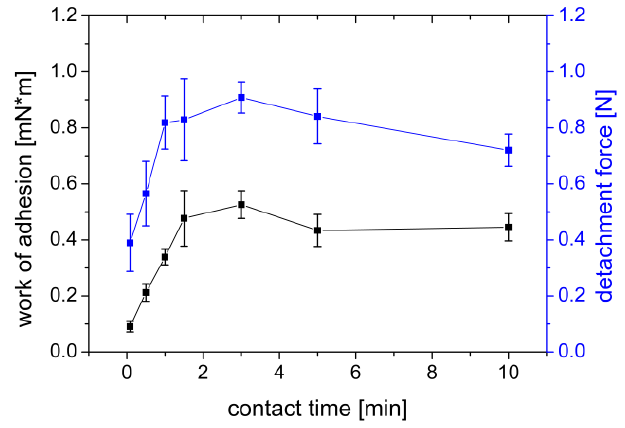
Figure 5. Influence of contact time of a PVA film on work of adhesion (mN × m) and detachment force (N) measured on a gel of 2% agar and 4% mucin. Mean ± SD, n = 6.